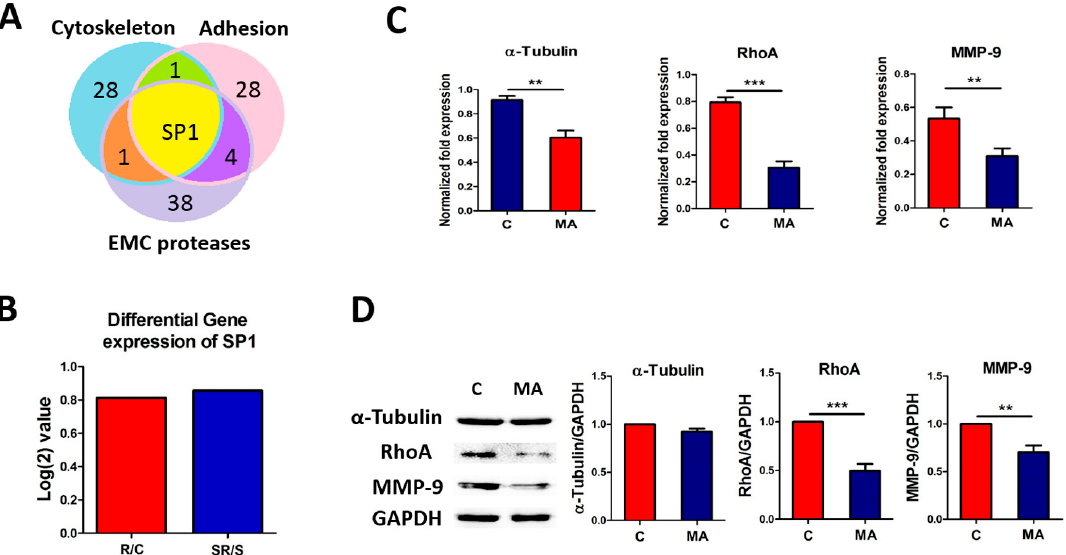
Figure 6. Expression of SP1, the common transcription factor predicted by bioinformatics analysis between differentially expressed metabolism-associated genes, was evaluated following MA inhibitory treatment. ( A ) Three genes were chosen from each metastasis-associated category for use in predicting common transcription factor regulators. The number of transcription factor is shown in the unique or common regions of the Venn diagram; ( B ) The gene expression of SP1 is upregulated in the radiation ( vs. control) and starvation-radiation ( vs. starvation) groups; ( C ) Real-time Q-PCR revealed that the expression of α -Tubulin, RhoA, and MMP-9 at the RNA level were decreased after MA treatment; ( D ) α -tubulin expression showed no significant change by western blot, but RhoA and MMP-9 were down-regulated at the protein level after MA treatment. GADPH served as loading control for western blot analyses. The data represent the means ± S.D. of three independent experiments. C, Control; R, Radiation; S, starvation; SR, starvation + radiation; MA, mithramycin, ** p < 0.001, *** p < 0.0001 versus different treated groups.